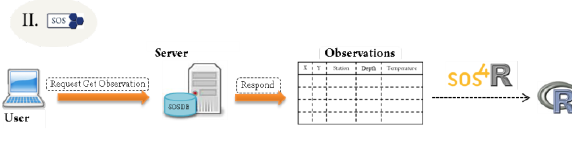
Figure. 4. Option II. Only